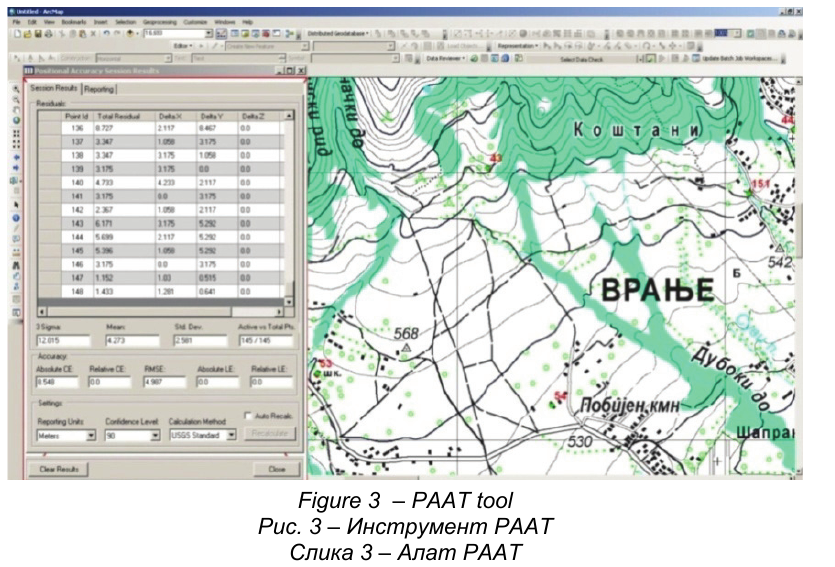
Figure 3 – PAAT tool Рис . 3 – Инструмент PAAT Слика 3 – Алат